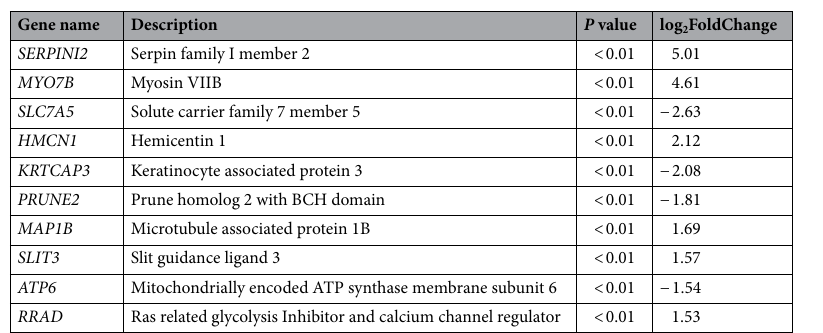
Table 3. Top 10 differentially expressed genes in HME vs LME in late fattening phases. DEGs: differentially expressed